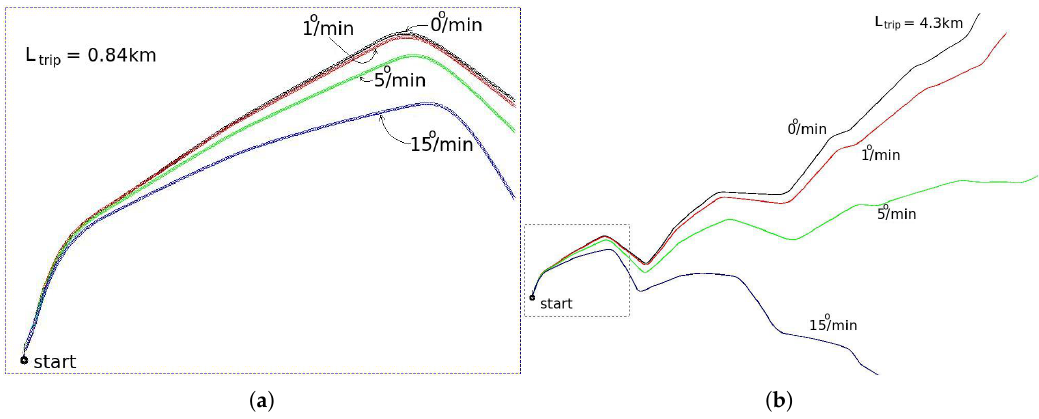
Figure 17. Effect of bias over the track reconstructed by dead reckoning: ( a ) Initial section with 0.84 km; ( b ) Complete section with 4.3 km.